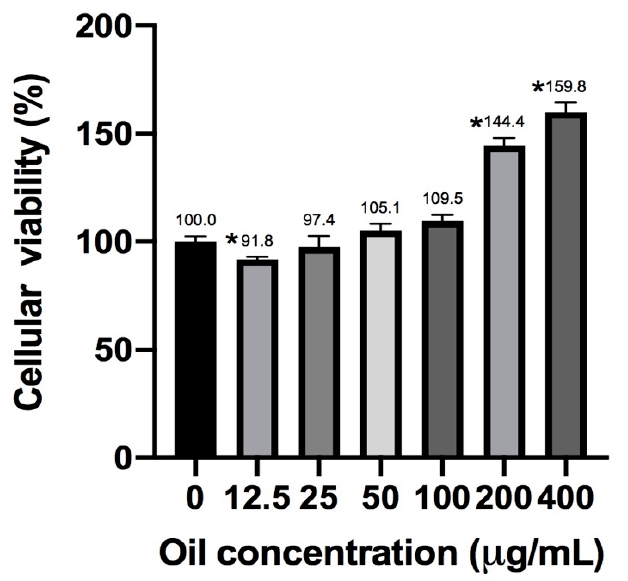
Figure 1. Cellular viability assay